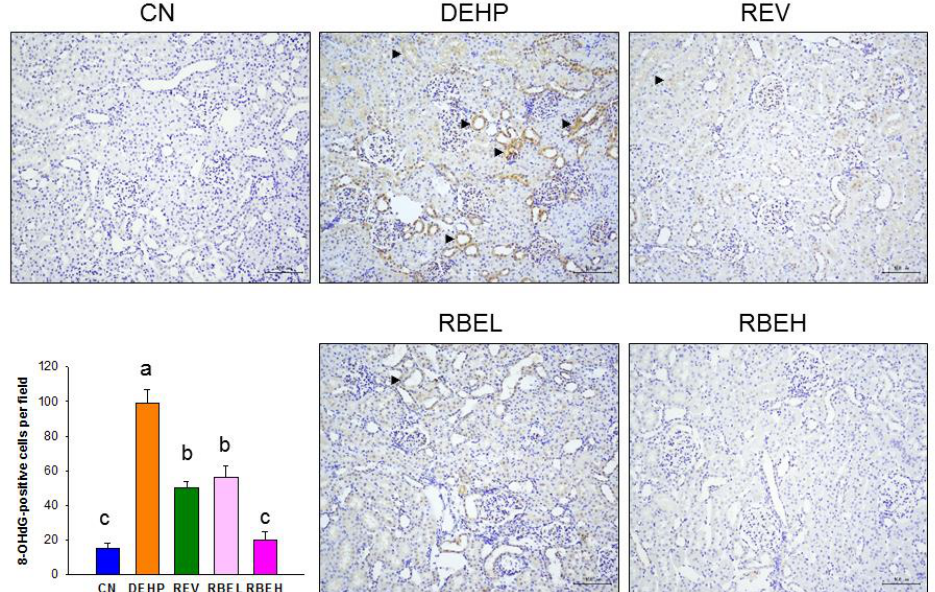
Figure 3. Light micrographs illustrating immunostaining for 8-OHdG in the 12-week-old male offspring kidney (200 × ). In the CN and RBEH group, 8-OHdG expression is almost negative. Immunostaining of 8-OHdG is at a moderate density in the glomeruli and tubules (arrowheads) in the REV and RBEL groups, and illustrating intense staining in the DEHP group. The letters a, b and c indicate the differences between the groups ( p < 0.05, one-way ANOVA with post hoc Tukey’s test); N =